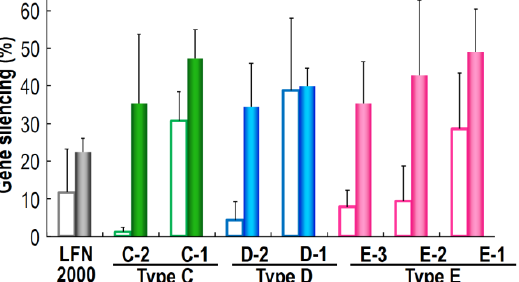
Figure 3. Investigation of the relationship between the hydrophobicity of the MCD and the gene silencing efficiency of the R8-D-MEND (MCD). The gene silencing efficiencies at 12 h after transfection were evaluated as described in Materials and Methods. Closed bars, 0.1 μg of siRNA; open bars, 0.04 μg of siRNA. Data are means ± S.D. (n =